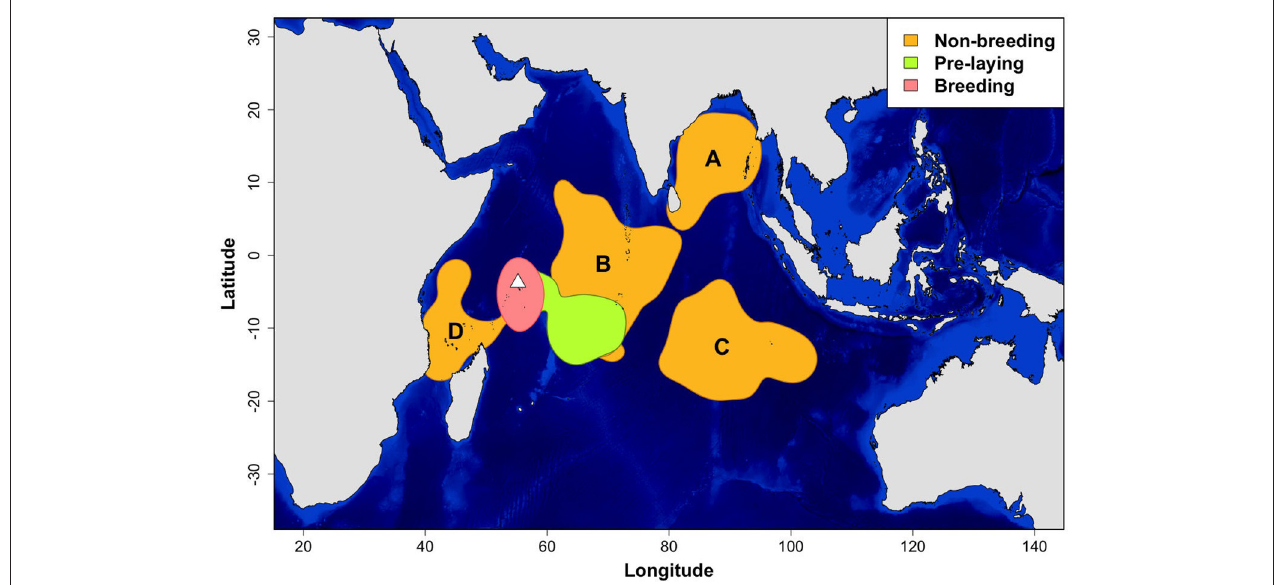
FIGURE 1 | Density distributions of sooty terns ( N = 36 birds and 53 annual tracks) from Bird Island (white triangle) during the non-breeding, pre-laying and breeding periods. Density contours encompass core areas (50% kernel). For the non-breeding period, locations were concentrated in four main areas: in the Bay of Bengal (A), on each side of the Chagos-Laccadive plateau (B), on each side of the 90 East Ridge (C), and around Comoros (D). Units are in